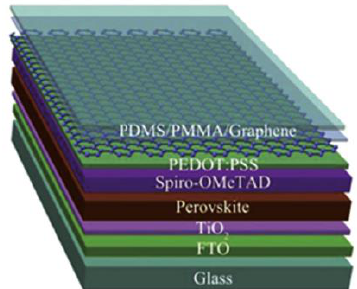
Figure 4. Schematic diagram of the semitransparent PSC using the graphene as top electrode. Reproduced with permission from reference [105].